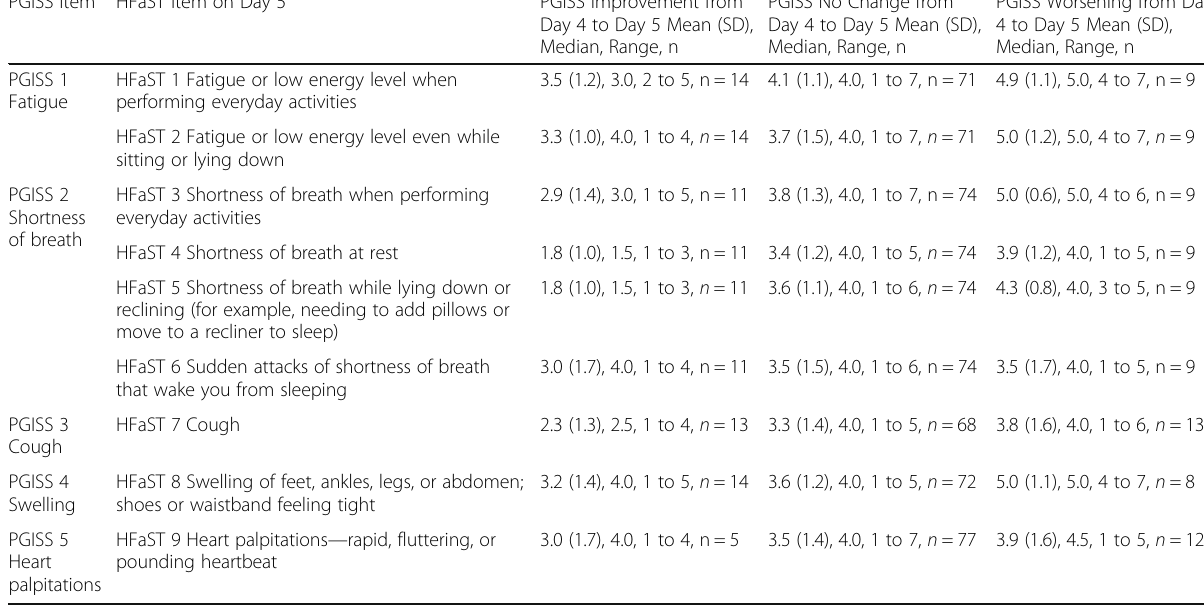
Table 4 Construct Validity and Responsiveness: HFaST Scores by PGISS Categories PGISS Item HFaST Item on Day 5 PGISS Improvement from